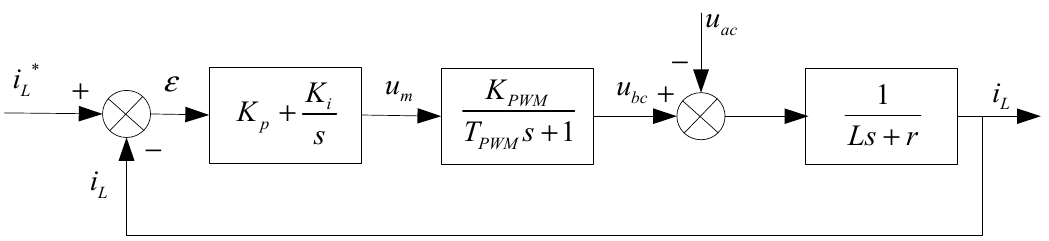
Figure 17. Current loop control block diagram of BSS-FBC.